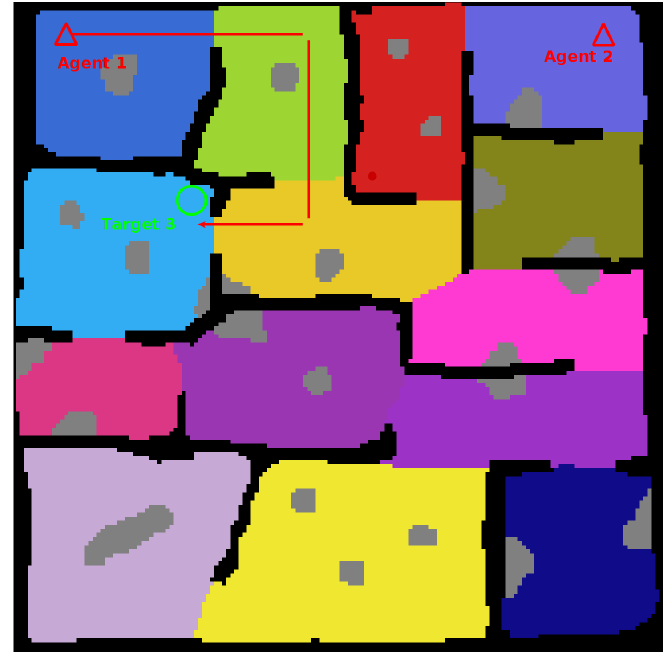
Figure 16. Target Three Test